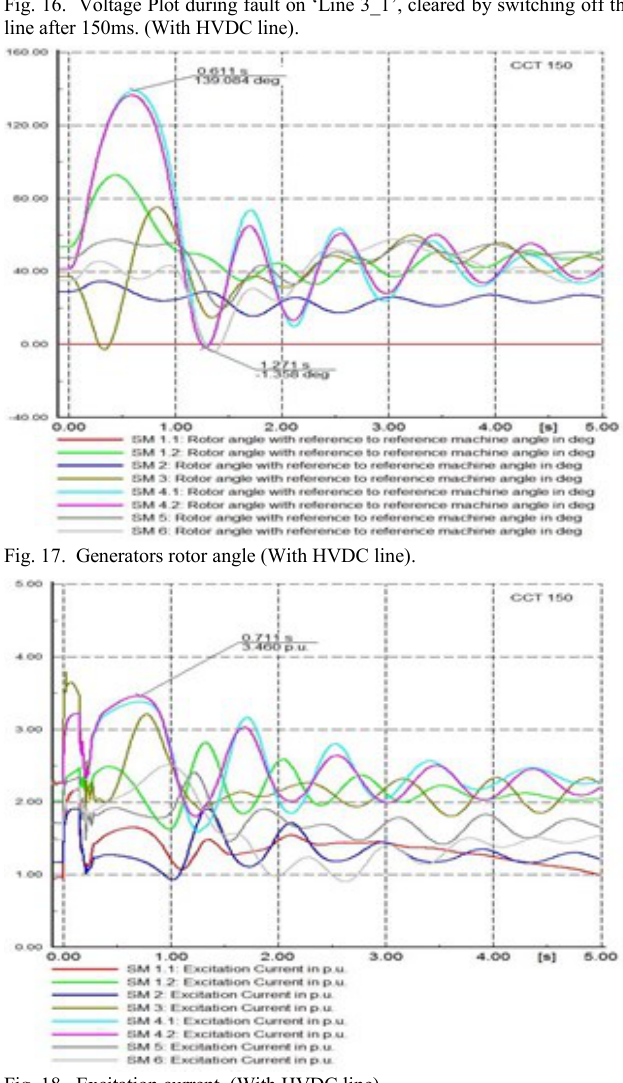
Fig. 18. Excitation current. (With HVDC